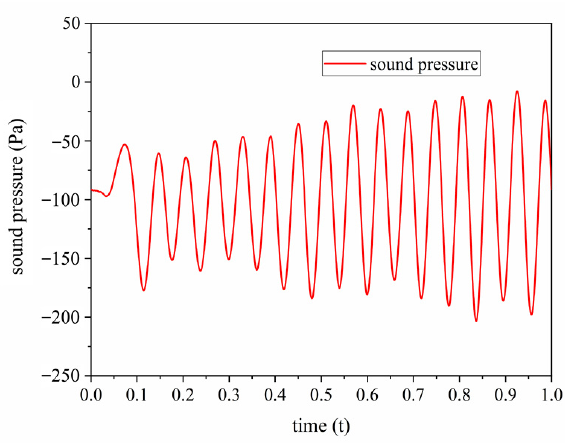
Figure 7. Pressure pulsation of the monitoring point while the inlet speed is 60 km/h.